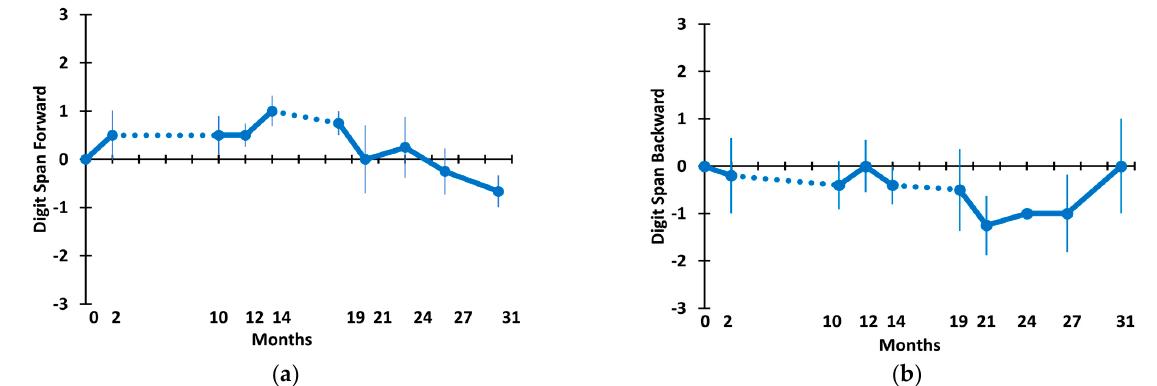
Figure 6. ( a ) Digit Span Forward and ( b ) Digit Span Backward through 31 months. Dotted lines indicate the 8M and 5M periods of no treatment.